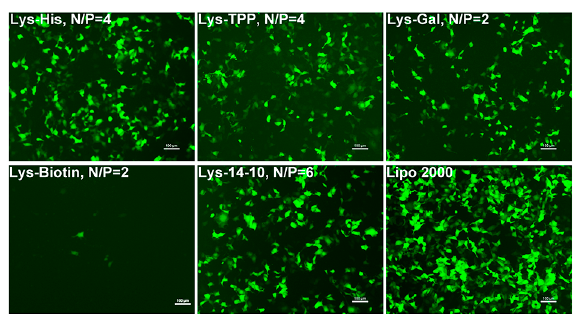
Figure 3. Fluorescent microscopy images of HEK 293 cells transfected by bolaplexes at the optimal N/P ratio (with the vector name and N/P ratio in each image). The molar ratio of bolaamphiphile/DOPE was 1:1, lipofectamine 2000 was used for comparison. The cells were observed by fluorescence microscopy after a 24 h transfection. Scale bar: 100 µ m.